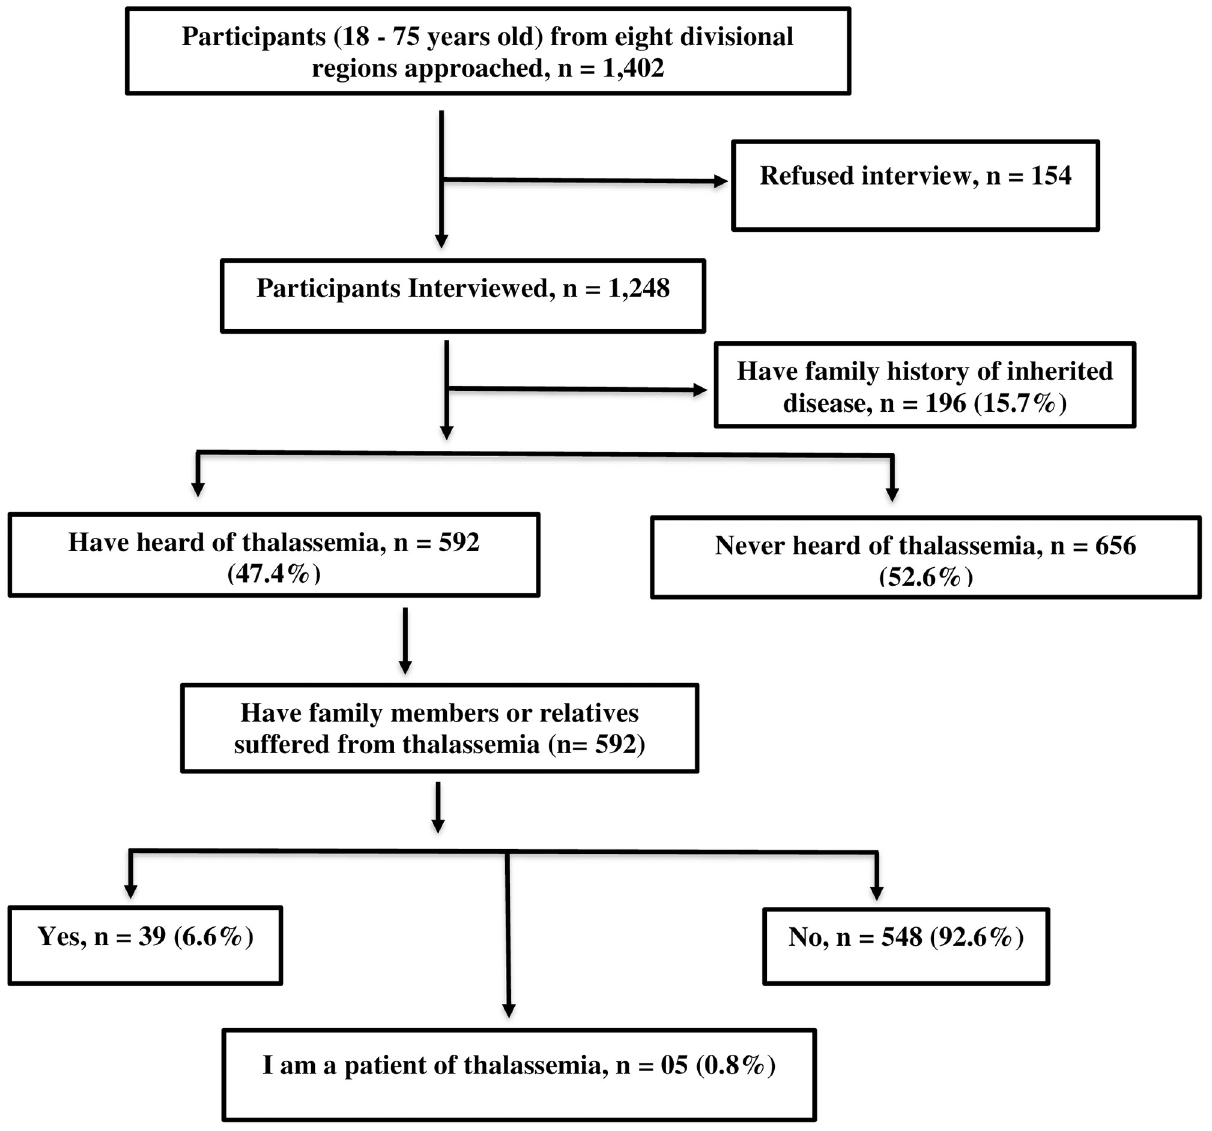
Fig 1. Participant’s family history of thalassemia